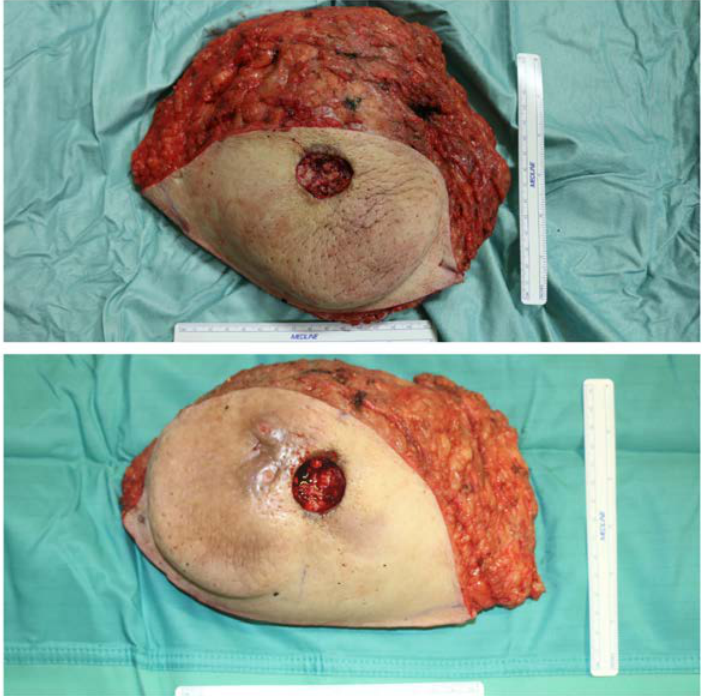
Figure 4. Appearance of excised breasts; size compared to a 15 cm measuring